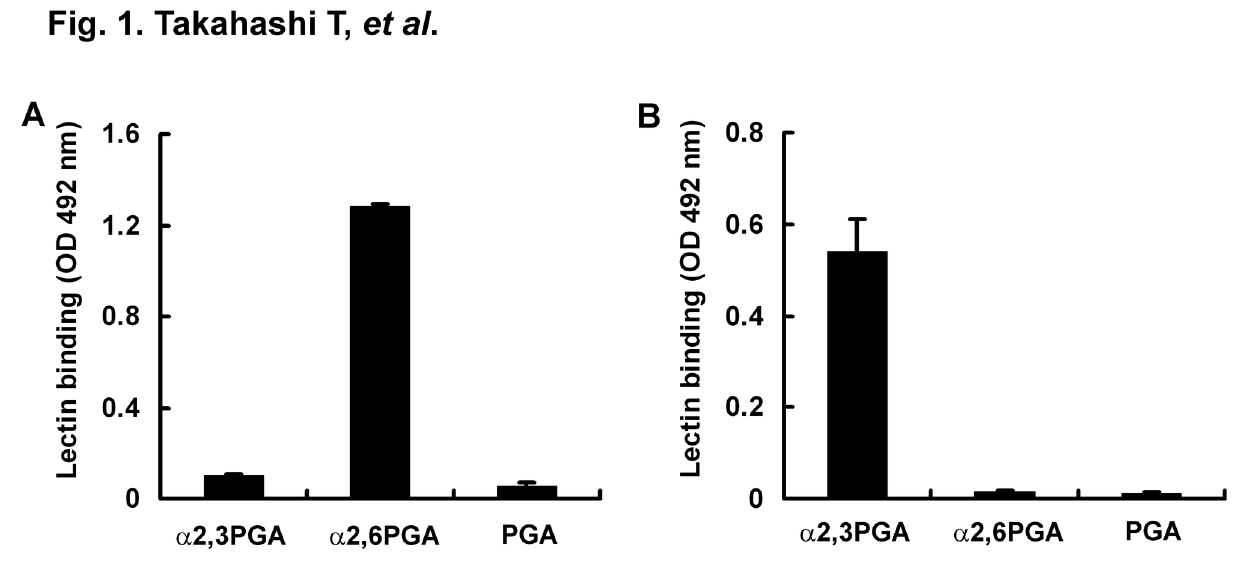
Figure 1. Lectin binding to PGAs immobilized on a microplate. α2,3PGA, α2,6PGA, and PGA containing an LacNAc chain (each 50 ng/well) on a microplate were reacted with biotinylated lectins, SNA (A) and MAM (B). Each value (standard error; S.E.) is the average from three independent experiments. OD, optical